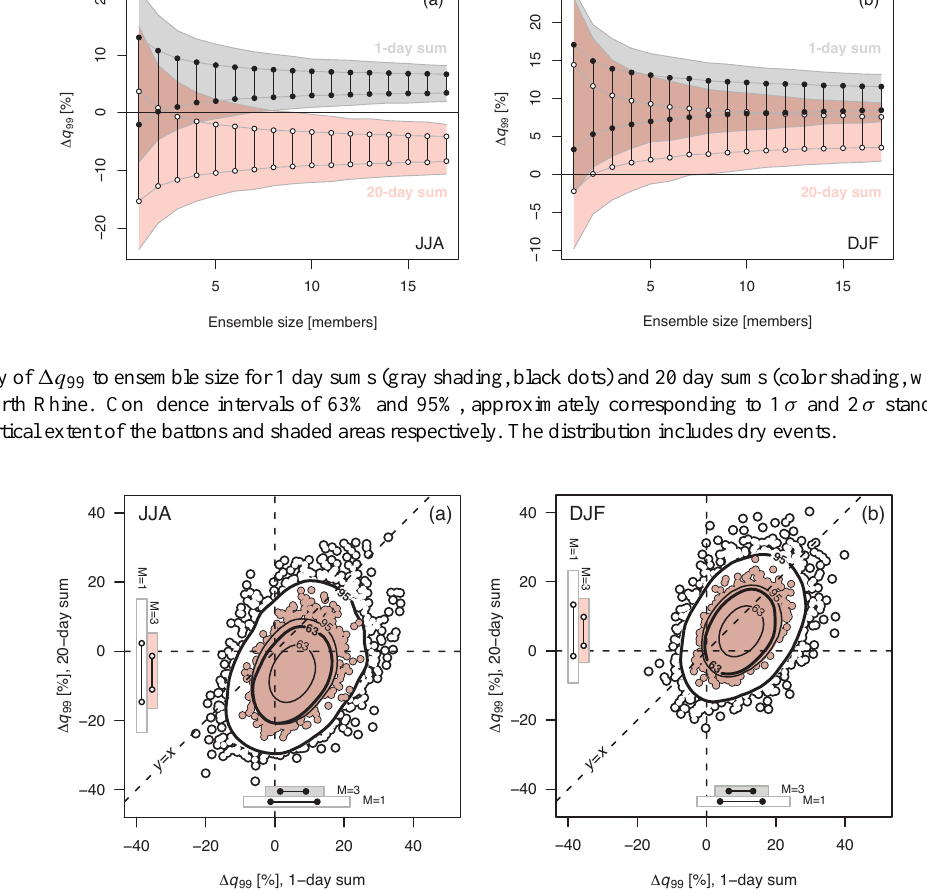
Fig. 7. Density plots for JJA (a) and DJF (b) showing the relationship between the 1-day sum- and 20-day sum-values of ∆ q 99 found in the bootstrapped samples of Fig. 6 for ensembles with M = 1 (white points) and M = 3 (color points) members. Density contours enclosing 63% and 95% of the data cloud are drawn (thick for M = 1 , thin for M = 3 ). They illustrate the magnitude of uncertainty associated